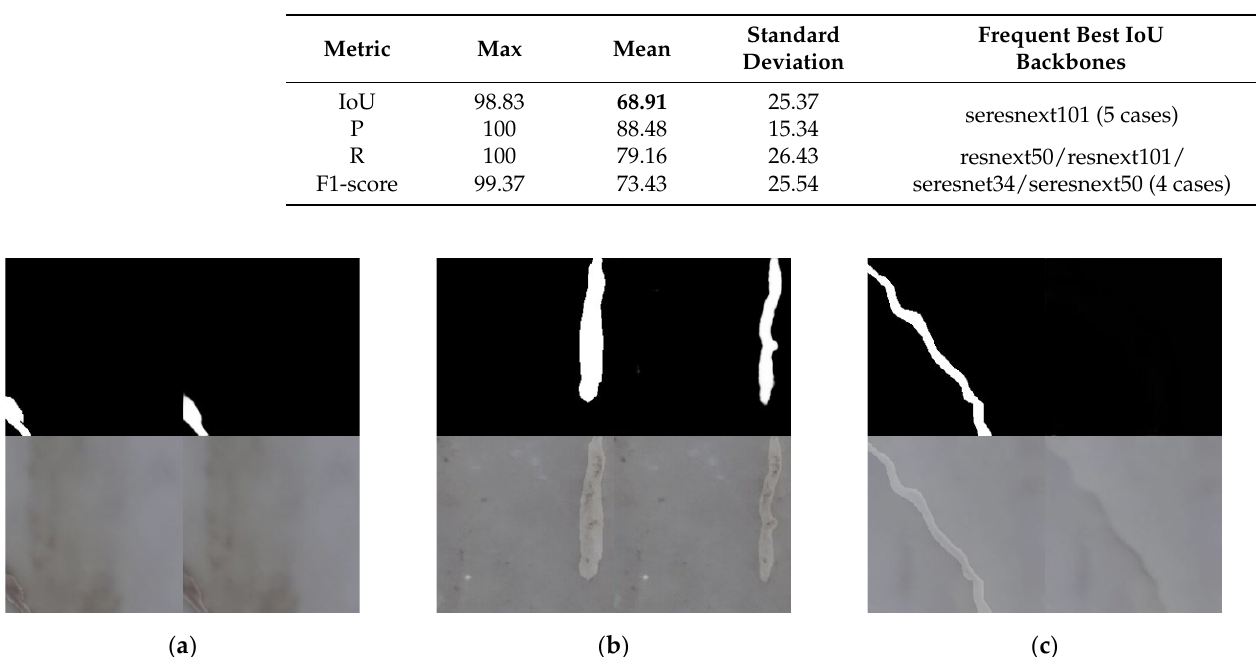
Table 6. Performance (%) of U-Net on the test set after 5-fold cross-validation. Best mIoU is marked in bold font.